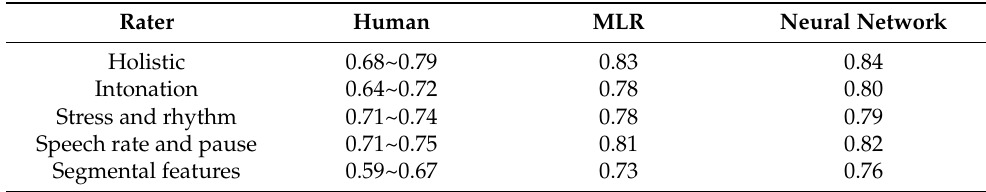
Table 8. Correlation between human rater and proposed proficiency scoring system with data